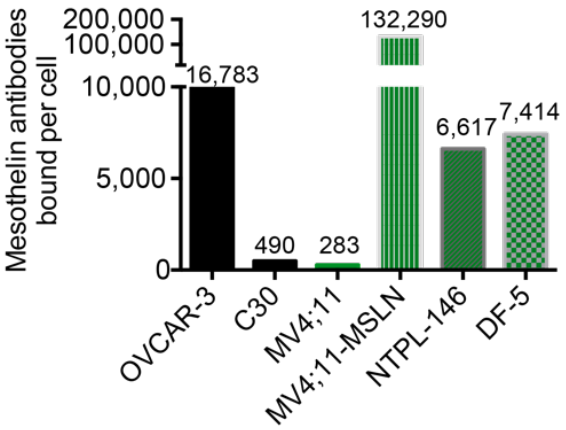
Figure 1. MSLN cell surface expression and quantitation in AML cell and PDX lines. Quantitation of MSLN antibodies bound per cell using Quantibrite. Ovarian carcinoma cell lines OVCAR-3 (MSLN-positive) and C30 (MSLN-negative) were used for reference.